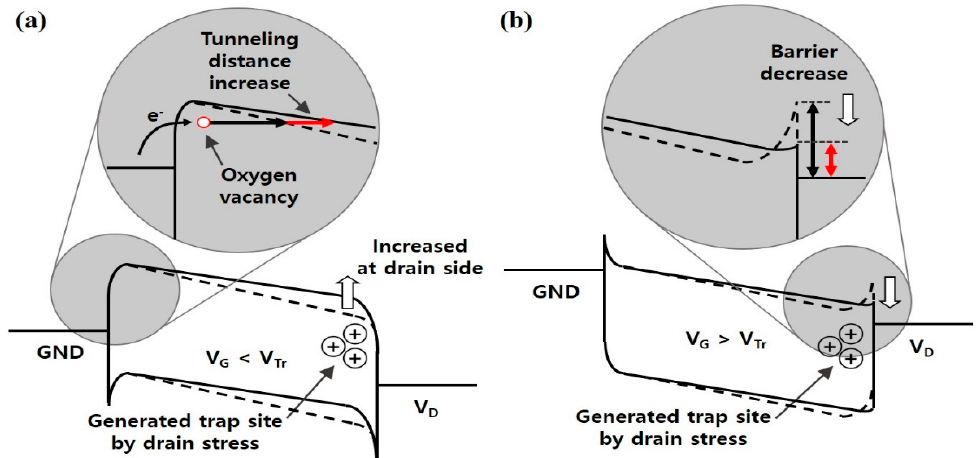
Figure 4. ( a ) Energy band diagram when the V G is lower than the V Tr with the enlarged region at the source/channel side. The tunneling distance of TAT (red arrow) increases due to the change in the potential barrier by positive charge traps near the channel/drain side; ( b ) Schottky barrier is lowered due to the charge traps when the V G is larger than the V Tr near the channel/drain side after stress.